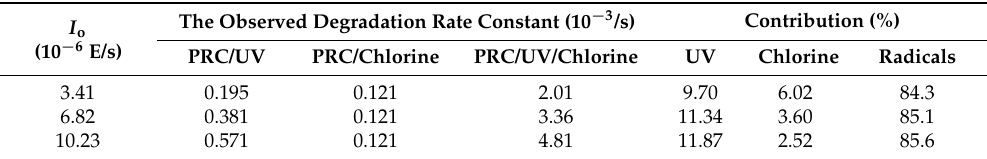
Table 2. Contribution percentage of UV, chlorine, and reactive radicals to the PRC degradation by the UV/chlorine process under different UV light intensities ( I o ).